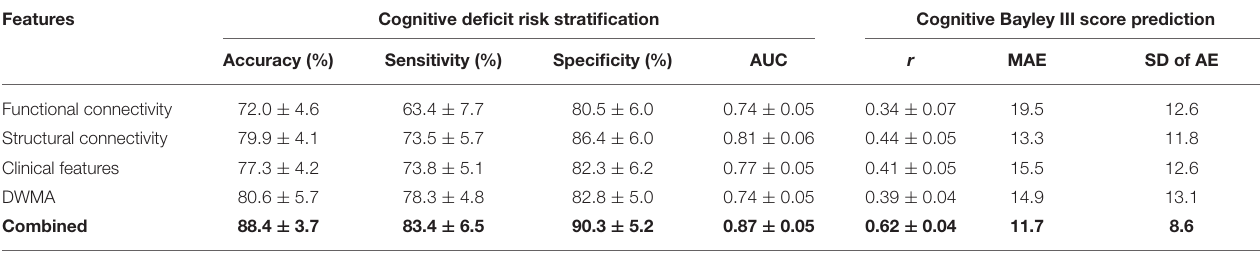
TABLE 4 | Performance comparison shows that our proposed deep multimodal learning model that uses combined feature sets (i.e., functional connectome + structural connectome + clinical data + DWMA) obtained at term-equivalent age outperforms each individual feature set for early identification of very preterm infants at high-risk for cognitive deficits and predicting their actual Bayley III Cognitive scores at 2 years corrected age.